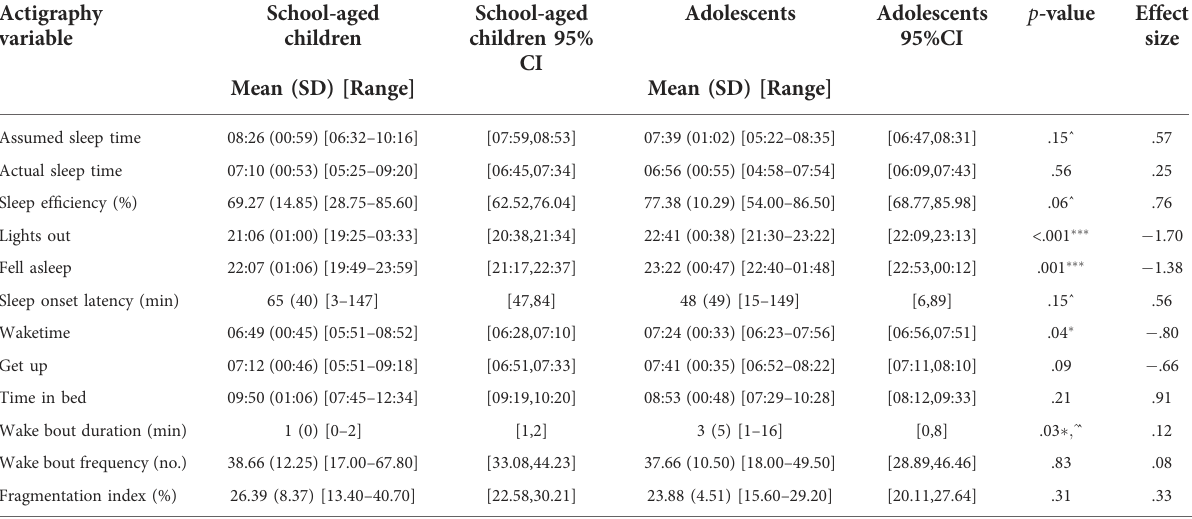
TABLE 4 Sleep pro fi les of children according to their age group based on actigraphy and sleep diary data. Actigraphy variable